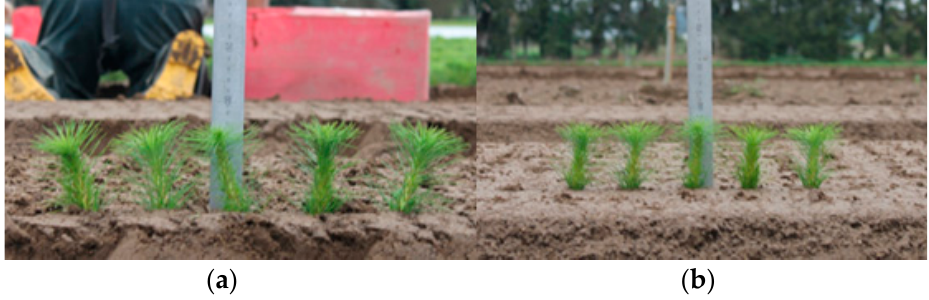
Figure 16. Cuttings placed in the dibbled holes. ( a ) Holes dibbled by the spiked wheel. ( b ) Holes dibbled by the dibbler.